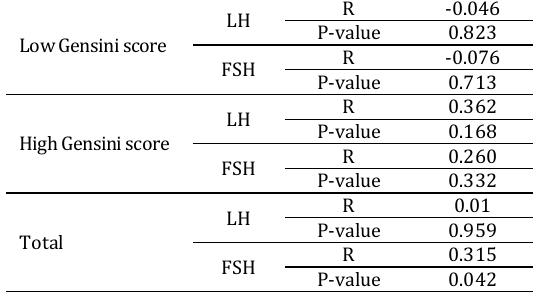
Table 2. Evaluation of the relationship between Gensini score and levels of LH/FH in separate groups and in study population by Pearson correlation